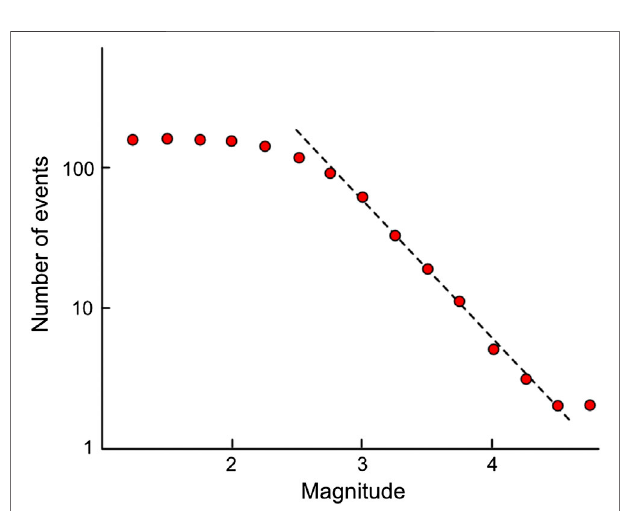
FIGURE 4 | Number of Ayiti-séismes determinations as a function of magnitude illustrating a completeness magnitude between 2.5 and 3 Mlv.